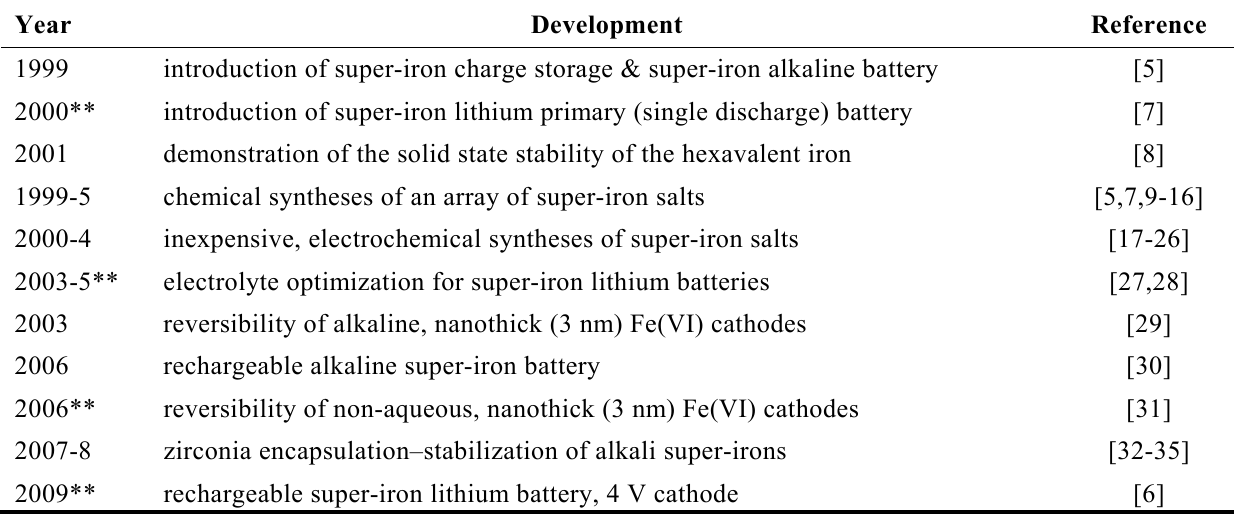
Table 1. Timeline of Fe(VI) charge storage